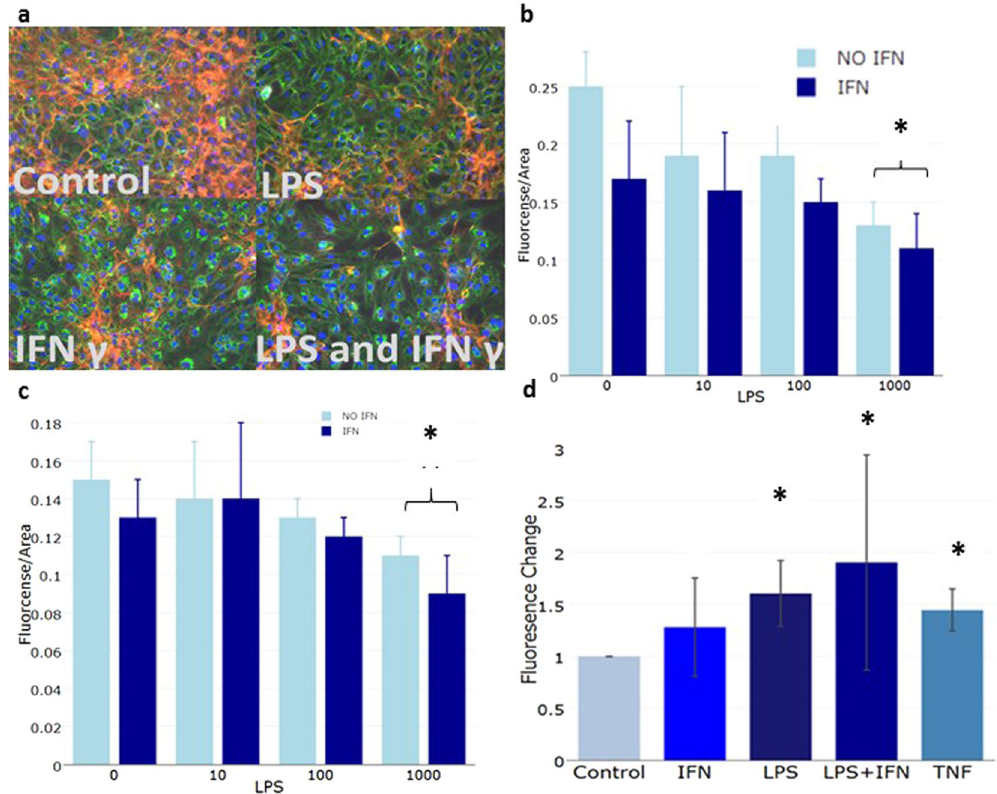
Figure 3. LPS and IFN γ treatment of HUVECs result in glycocalyx loss, increased permeability and changes in cellular metabolism. ( a ) Fluorescent images of HUVECs control or treated with 50 µ g/mL IFN γ , 1000 ng/mL LPS for 24 h or a combination of the two (LPS/IFN γ ) stained with DAPI (nucleus, blue), wheat germ agglutinin (negatively charged glycocalyx components, green) and heparan sulfate proteoglycan 2 antibody (red). ( b ) Normalized change in heparan sulfate signal by LPS concentration and IFN γ . Full statistics Supplement ixb. ( c ) Normalized change in wheat germ agglutinin signal by LPS concentration and IFN γ . Full statistics in Supplement ixa. ( d ) Normalized change in fluorescence, indicating permeability, in a transwell assay, over 45 minutes after treatment with IFN γ , LPS and tumour necrosis factor α (TNF α ). ( * significant at p < 0.05).